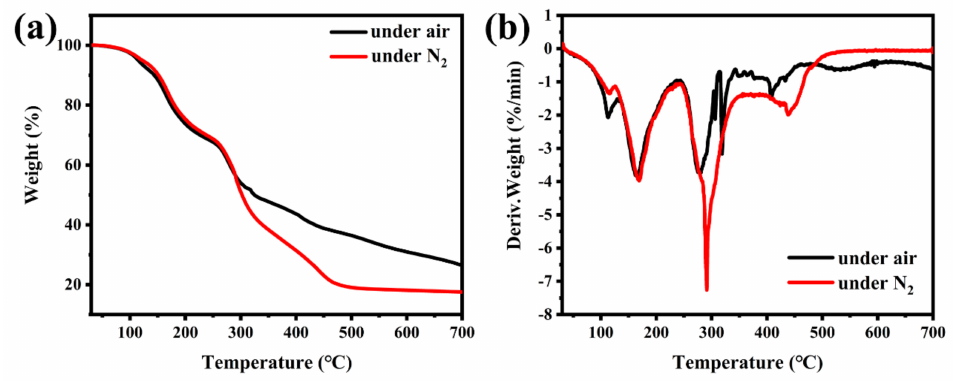
Figure 4. TGA curves ( a ) and DTG curves ( b ) of TBPBP under N 2 and